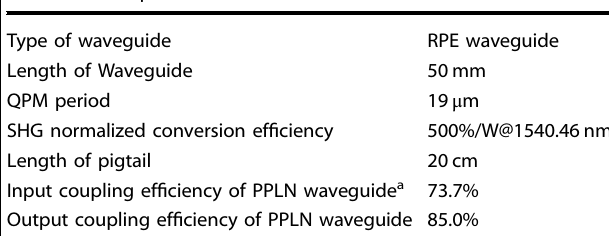
Fig. 1 The design of the PPLN waveguide module and the measured spectra of created photons in the module. a The design of the PPLN waveguide module. The input pump photons at λ p pass through the fi lter (F1), with the input noise photons removed. The SpRS process takes place in the two fi ber pigtails, while the cascaded SHG/SPDC processes occur in the PPLN waveguide. After fi lter (F2), the residual pump light is smaller than the input one by about ~ 20 dB, which could reduce the SpRS noise photons by ~ 100 times in per unit length of the fi ber. b Measured spectra of correlated photon-pairs with phase matching. c and d are the measured co- and cross-polarized Raman spectra in the PPLN waveguide module under the phase mismatching condition. Table 1. Main parameters of PPLN